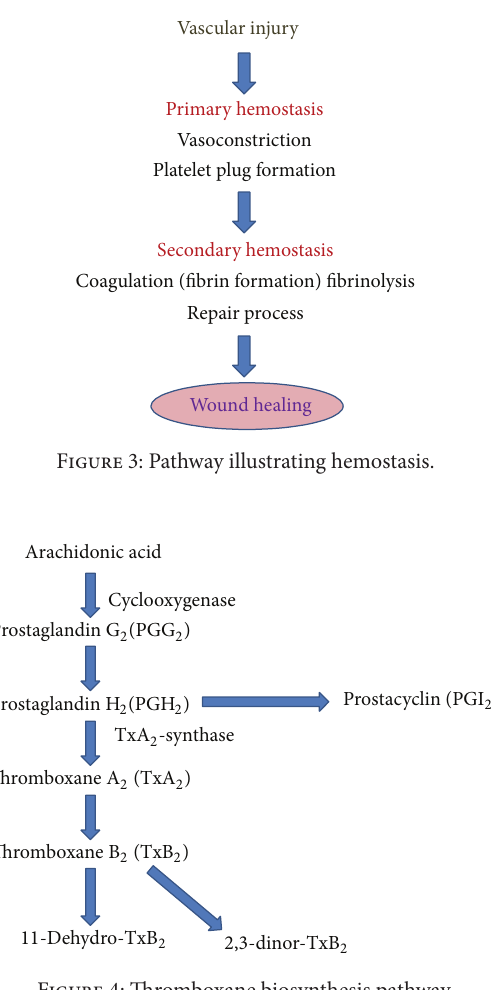
Figure 4: Thromboxane biosynthesis